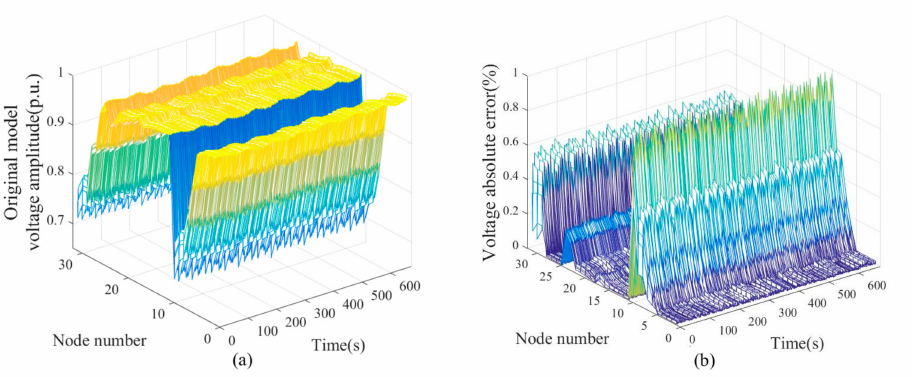
Figure 9. Dynamic simulation result of the internal system. ( a ) Voltage variation of the original system. ( b ) Voltage absolute errors of the proposed equivalent model.